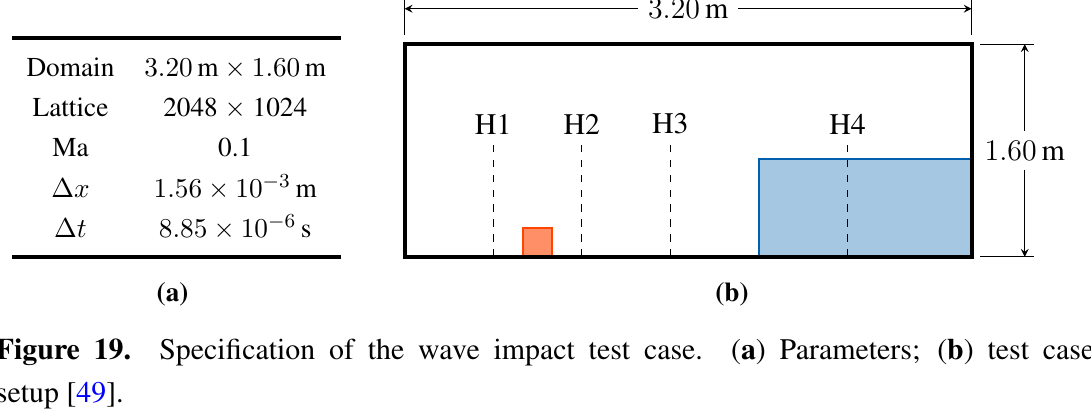
Figure 19. Specification of the wave impact test case. ( a ) Parameters; ( b ) test case setup